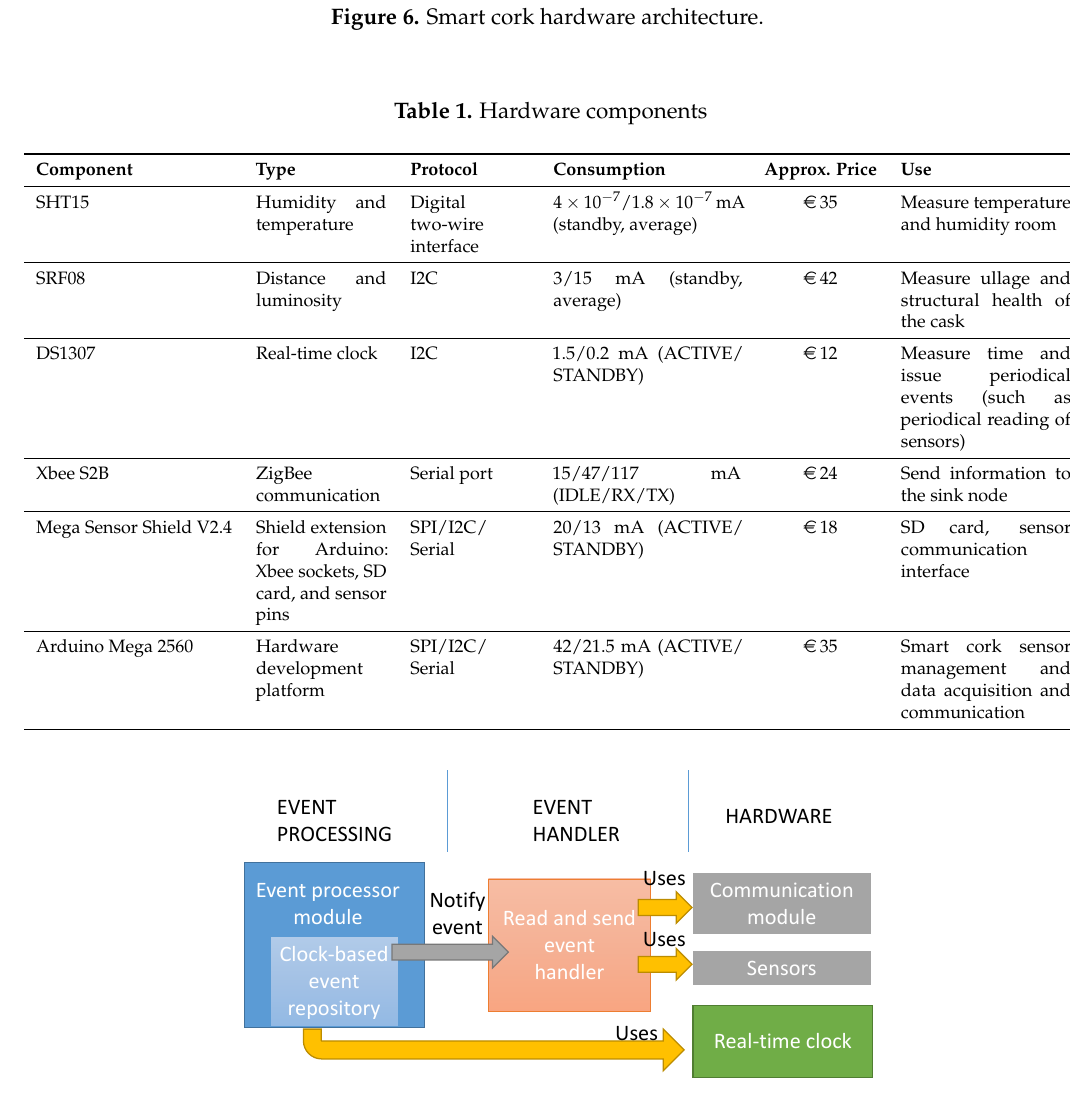
Figure 7. Firmware